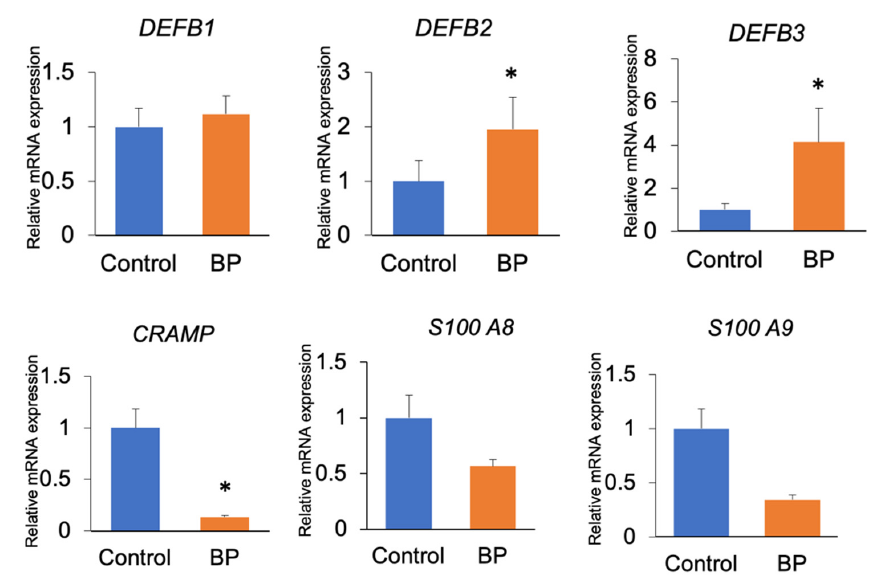
Figure 6. Relative mRNA expression levels of AMPs. DEFB2 and DEFB3 were significantly upregulated, whereas CRAMP (cathelicidin) was significantly downregulated in the buccal mucosae of mice from the BP group when compared to those in the control group (* p < 0.05). Data are expressed as mean and the error bars represent the standard error.